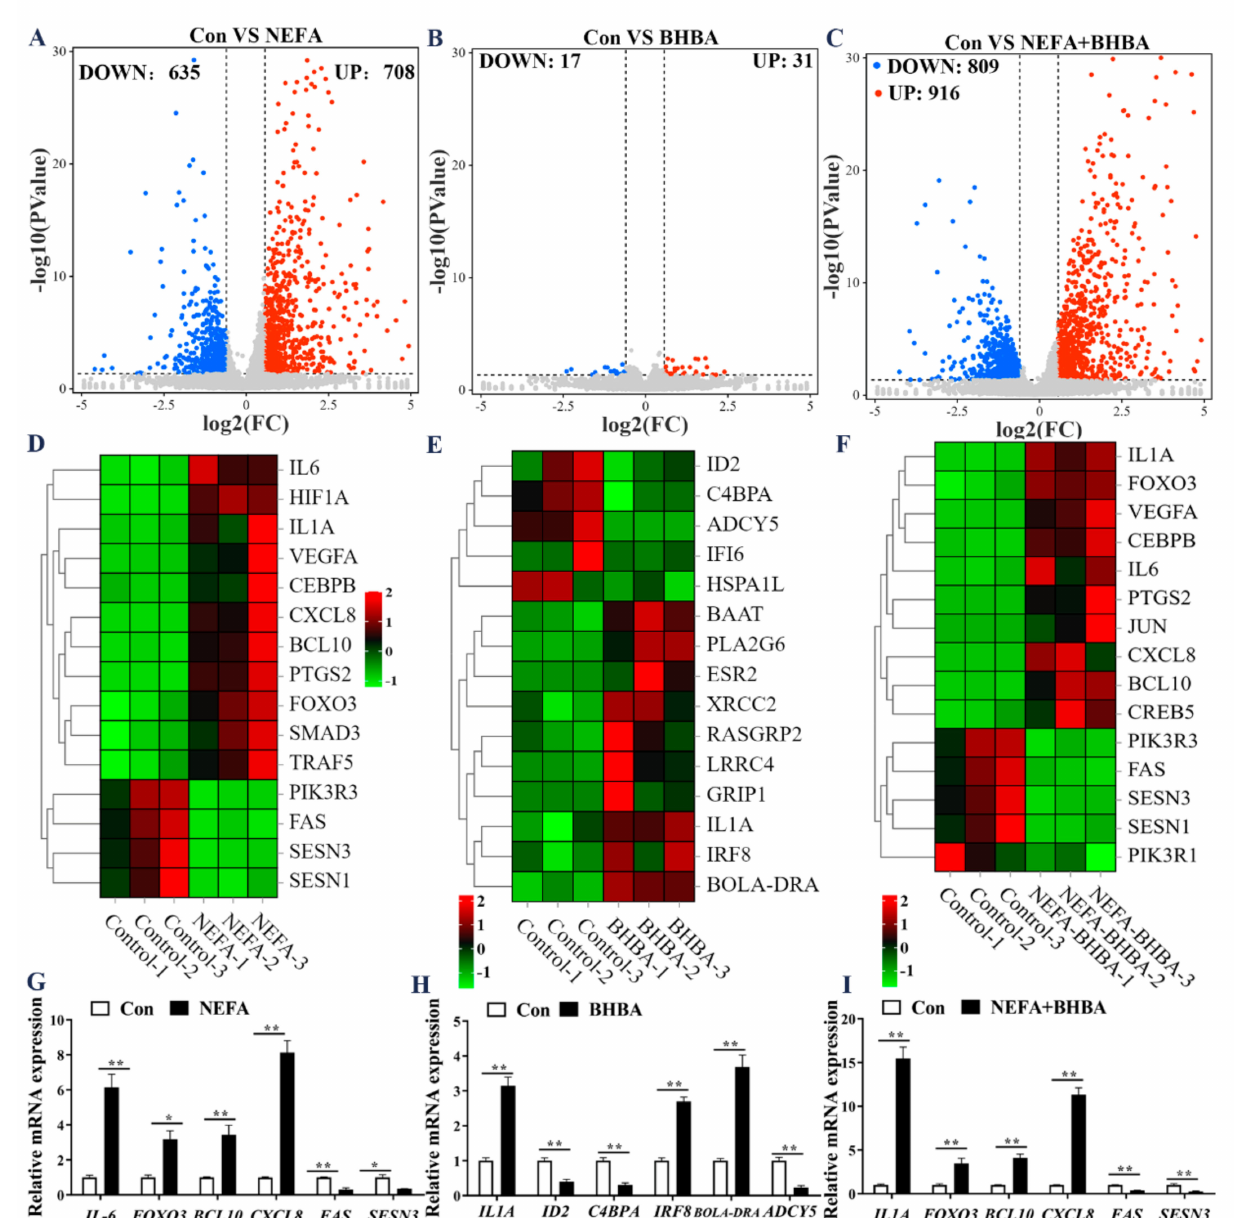
Figure 1. DEG analysis of BMECs treated with NEFA and BHBA. ( A ) Volcano of DEGs between control and NEFA treatment group in BMECs. ( B ) Volcano of DEGs between control and BHBA treatment group in BMECs. ( C ) Volcano of DEGs between control and combinative treatment (NEFA and BHBA) group in BMECs. ( D – F ) Heatmaps of DEGs involved in oxidative stress and inflammatory response in BMECs. ( G – I ) qPCR verification of the EDGs in BMECs treated with NEFA and BHBA. Data are presented as the means ± SEM of three independent experiments. * p < 0.05; ** p <